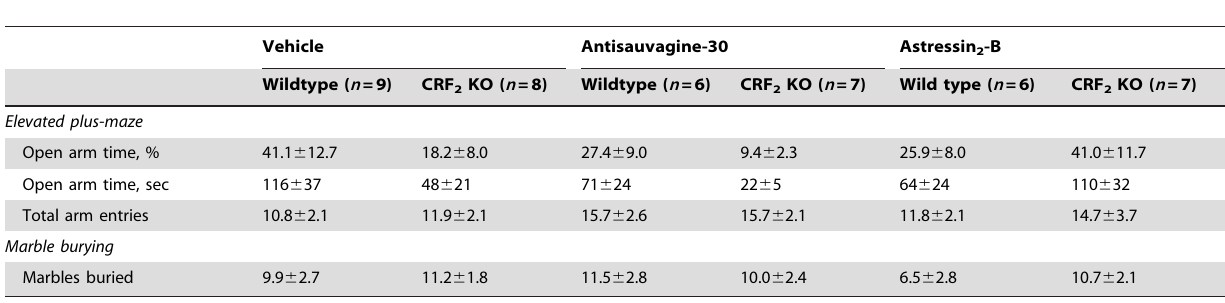
Table 2. Effects of genotype and CRF antagonist on behavior in the elevated plus-maze and marble burying tests.